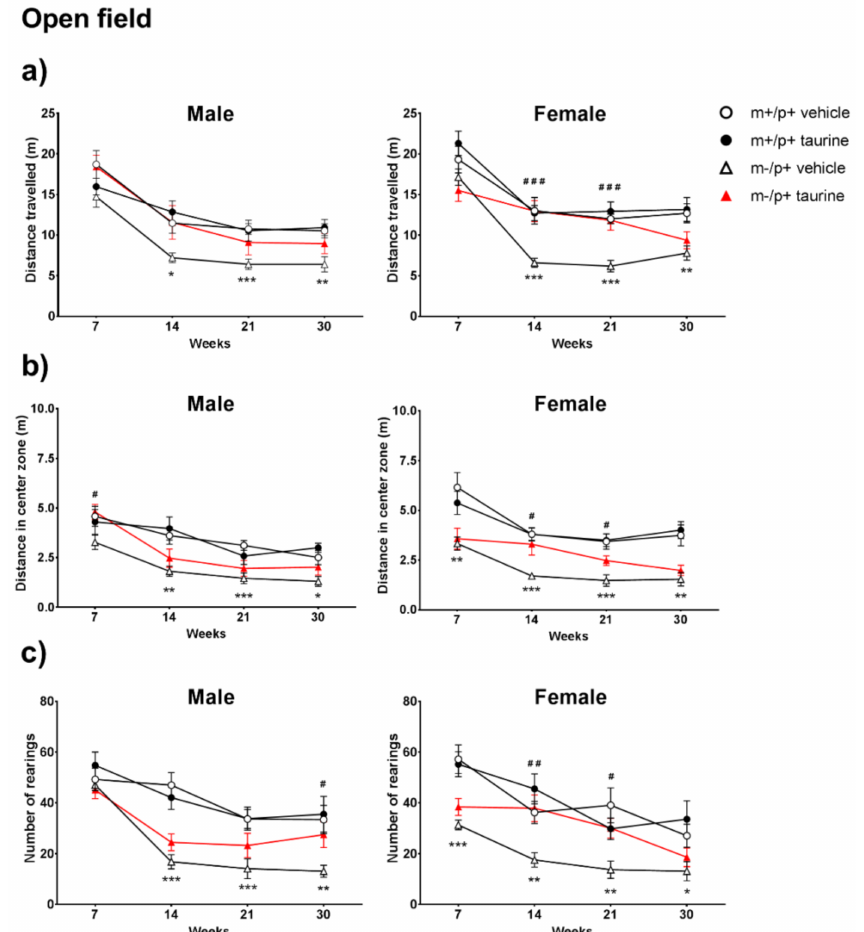
Figure 3. Taurine administration partially improved locomotor activity, anxiety and exploration in AS female ( Ube3a m − /p+ ) mice. Open field assay was carried out at four time points (7, 14, 21 and 30 weeks) on wild type (WT) and Ube3a m − /p+ mice (both treated (taurine) and untreated (vehicle)) by measuring ( a ) total distance traveled (m); ( b ) distance in center square (m) and ( c ) number of rearings. Analyses were conducted by separating genders (male: left panels; female: right panels). Number of animals per group: male mice (wt + vehicle = 13, wt + taurine = 12, Ube3a m − /p+ + vehicle = 11, Ube3a m − /p+ + taurine = 12); female mice (wt + vehicle = 13, wt + taurine = 13, Ube3a m − /p+ + vehicle = 11, Ube3a m − /p+ + taurine = 13). Data are shown, for each time point, as media ± SEM. Effect of genotype: * p < 0.05, ** p <0.01, *** p < 0.001; effect of taurine treatment on Ube3a m − /p+ genotype: # p <0.05, ## p <0.01, ### p <